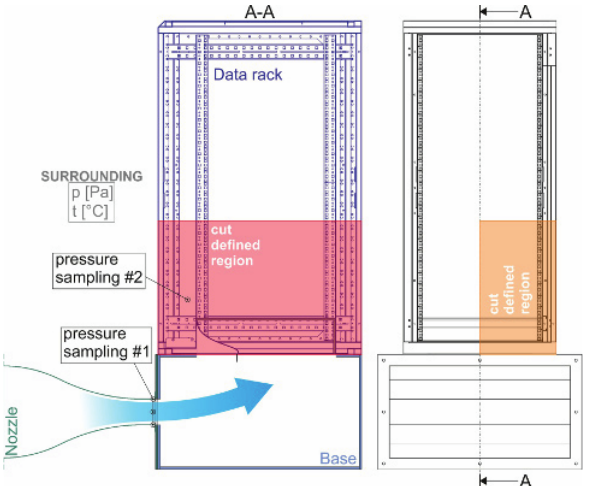
Fig. 1. Scheme used for experiment measurement.